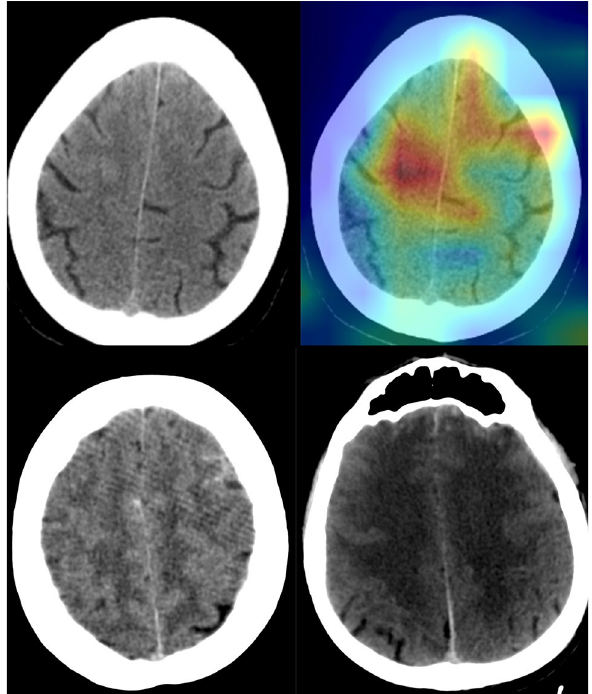
Figure 5. The presentative images of different patients in whom the model predictions were wrong (The images were created by the authors using open-source software, Matplotlib v3.5, Python v3). The original (the upper left) and corresponding normgrad images (the upper right) with a false-positive prediction are shown. In addition, the model overlooked the minor subarachnoid hemorrhage in the left frontal lobe (the lower